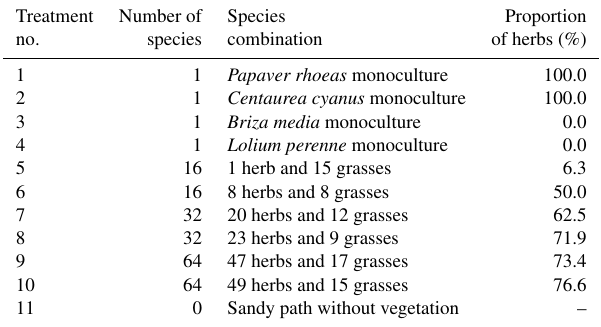
Table 1. Description of the 10 different meadow-like arrays and the bare ground